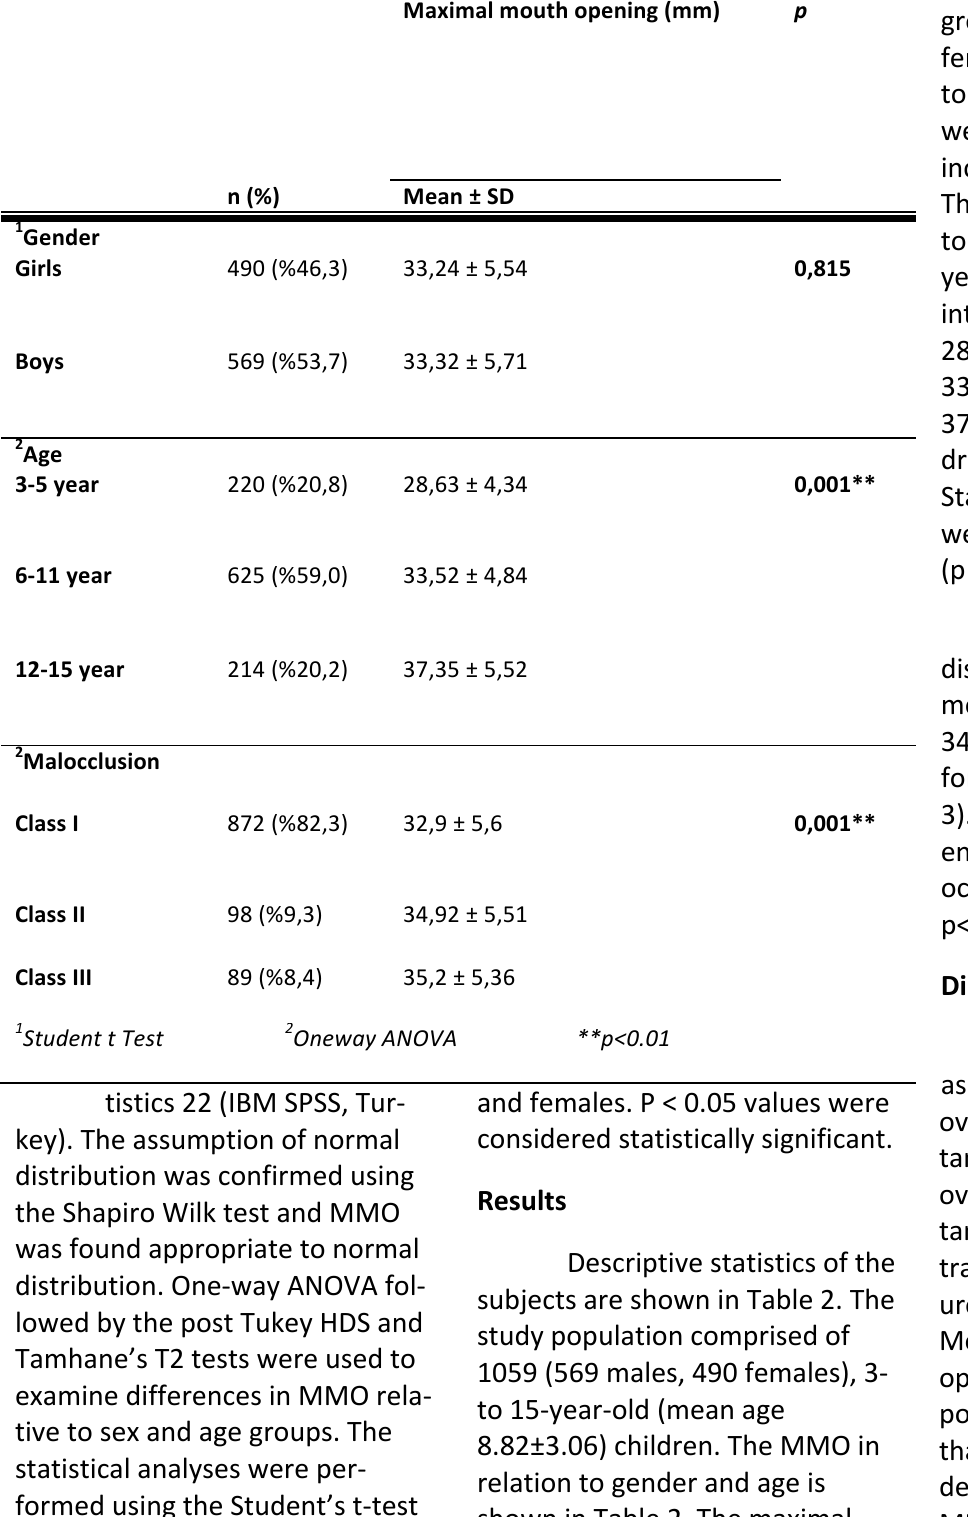
Table 2 . Distribu(on of maximal mouth opening according to gender, age , and ma l-­‐ occlusion